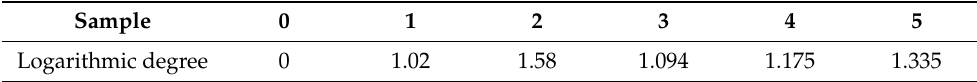
Table 2. Logarithmic degree φ of beating samples.